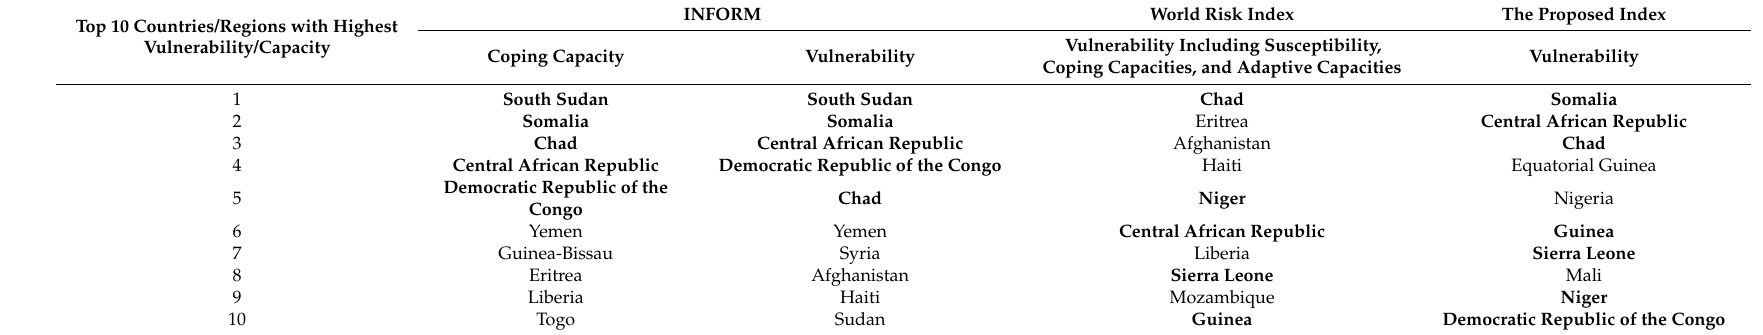
Table 3. The top 10 countries with the highest vulnerability/lowest coping capacity from the INFORM model, the World Risk Index, and the proposed index developed in this